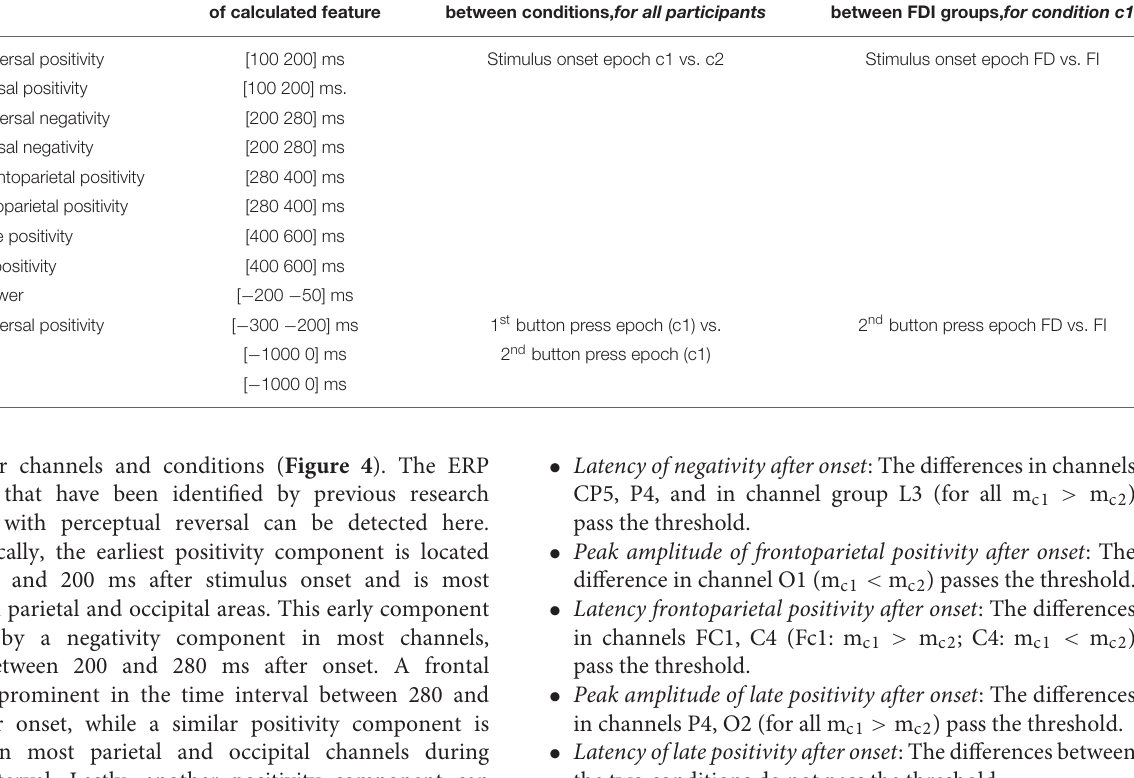
TABLE 1 | Comparisons that were performed for the current experiment: (a) between bistable and unambiguous conditions, and (b) between FD and FI participant groups.